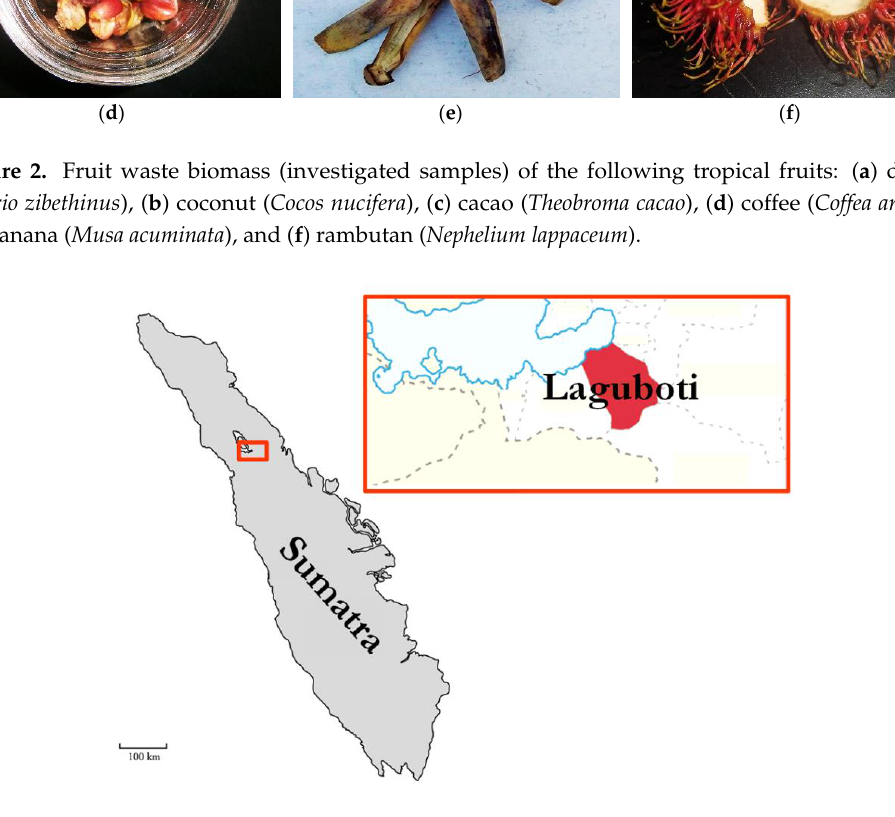
Figure 3. Laguboti district in North Sumatra, Indonesia. Table 1. Mass of investigated unprocessed fruit